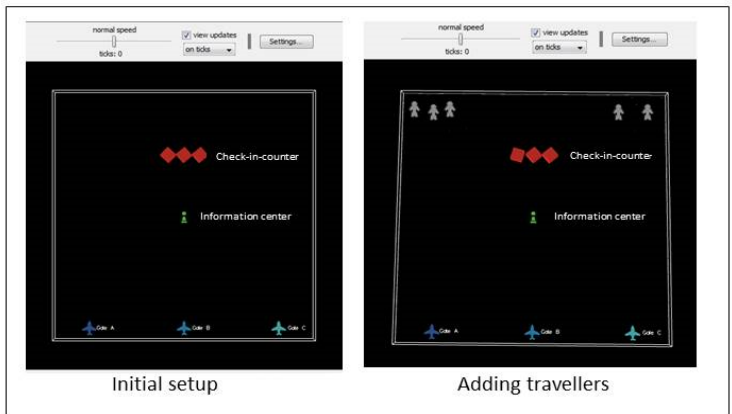
Figure 7. Initial view for the airport scenario.